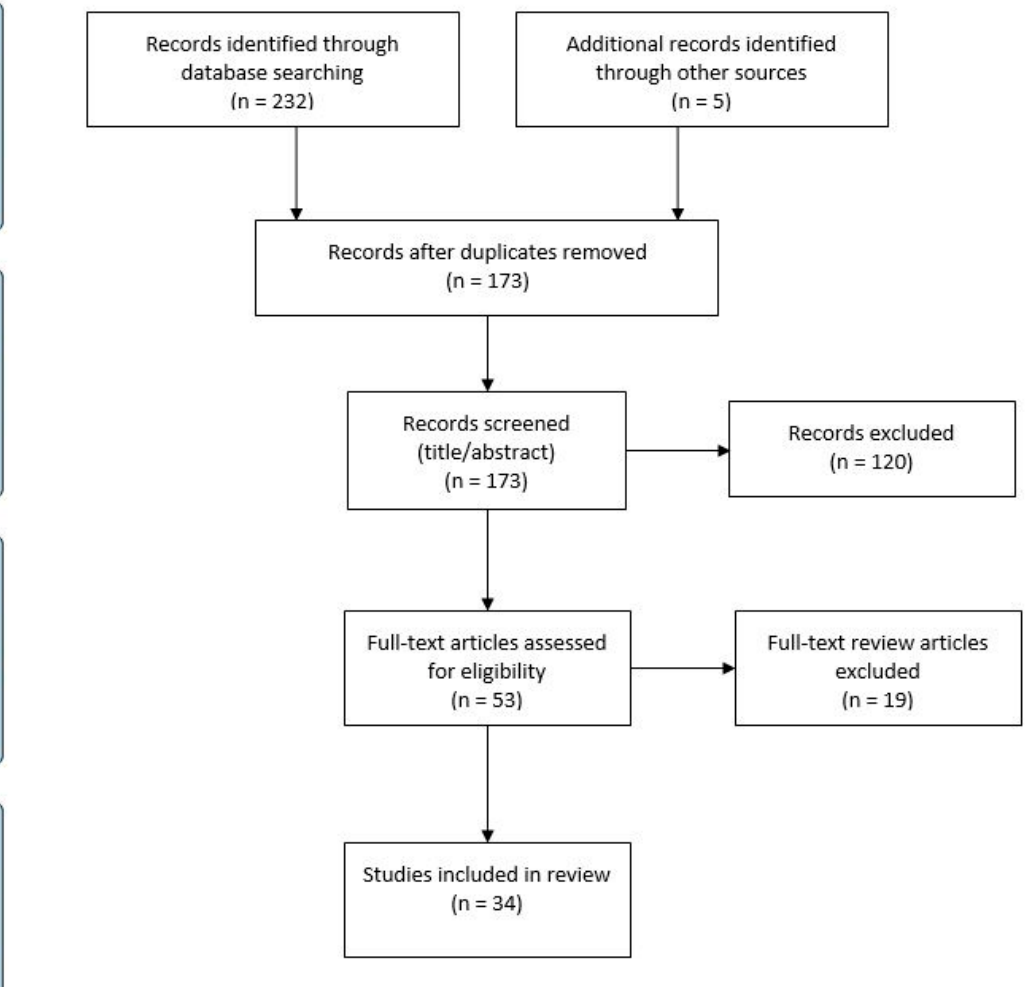
Figure A1. Preferred Reporting Items for Systematic Reviews and Meta-Analyses (PRISMA) flowchart demonstrating the process used to retrieve articles for this review.